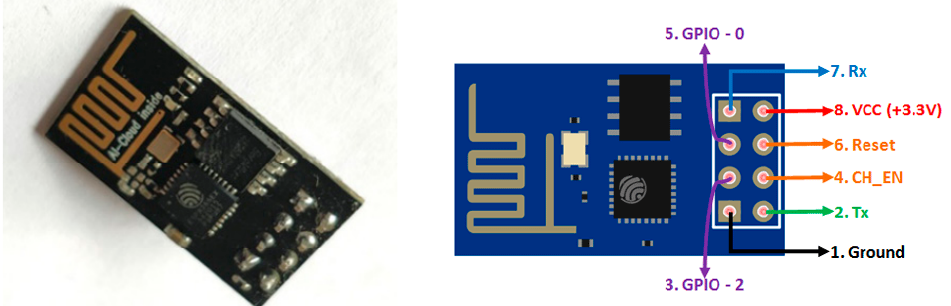
Figure 7. Espressif Systems Wi-Fi module ESP8266EX and pinout.